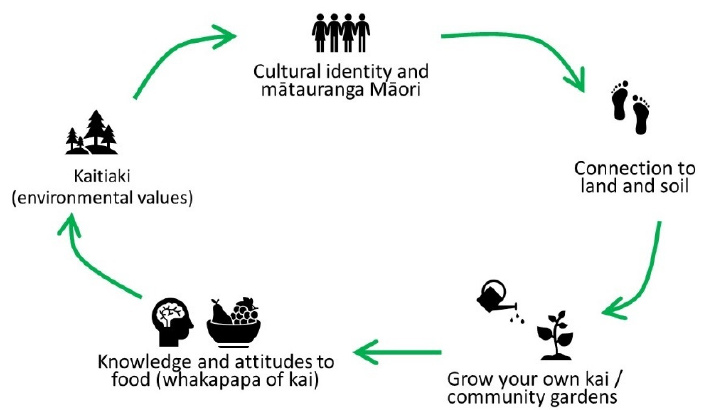
Figure Figure 4. Simplified loop as a communication tool about the chosen intervention point (m ā tauranga = knowledge; kai = food; whakapapa = origins) (See Supplementary Materials for the hand-drawn loop drafted by a participant during the workshops).